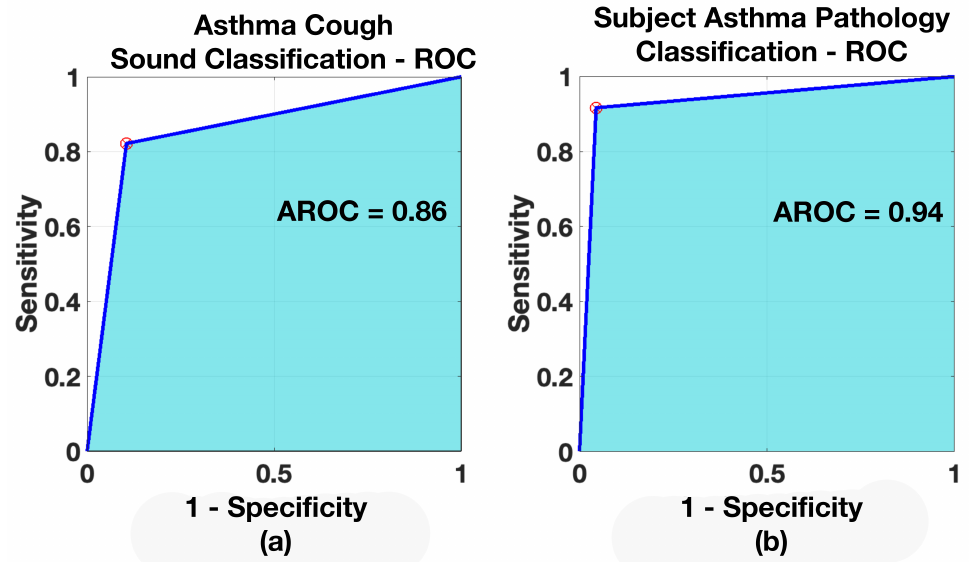
Figure 13. ROC— Healthy vs. Asthma Model : ( a ) when classifying Asthmatic coughs, ( b ) when classifying subject for